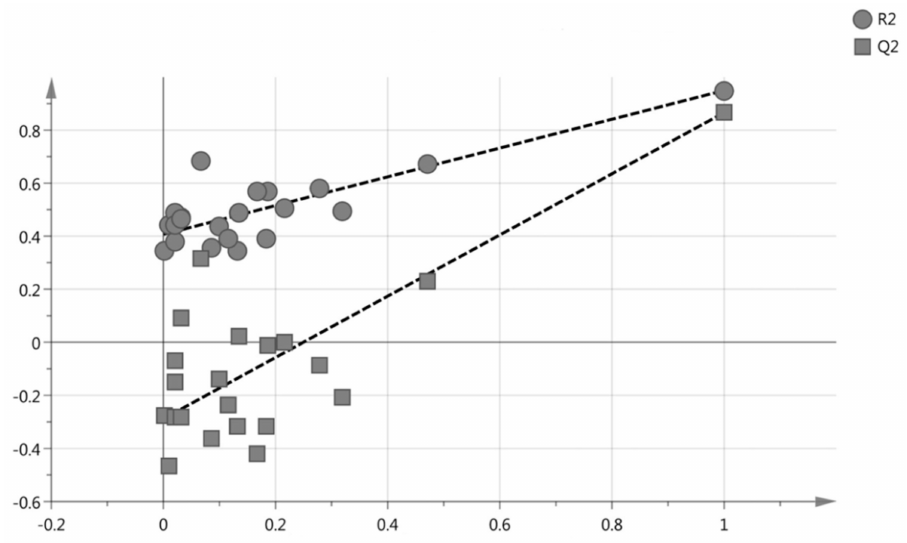
Figure 3. The permutation plot with the R 2 Y = 0.407 and Q 2 Y = − 0.288.